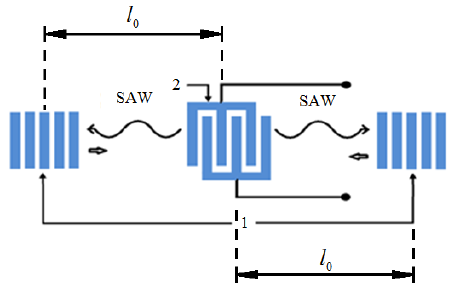
Figure 2. Surface acoustic wave resonator schematic illustration. 1 – reflectors; 2 — interdigital transducer